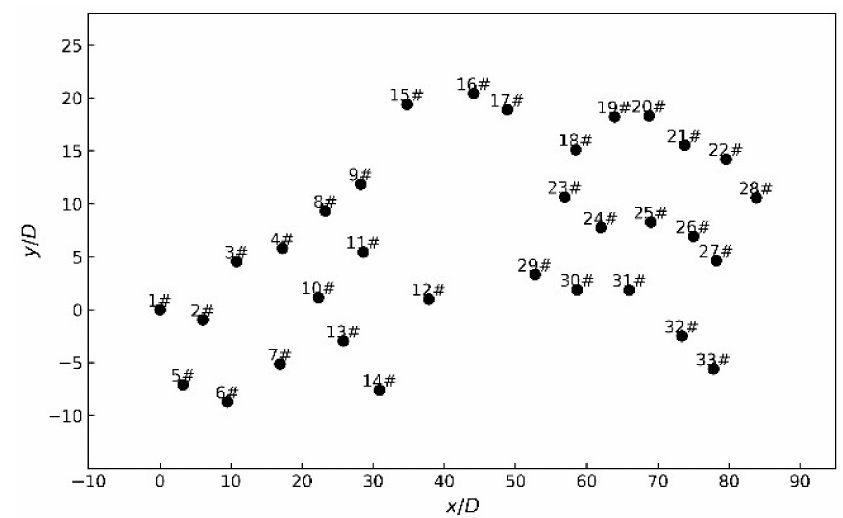
Figure 1. Layout of wind